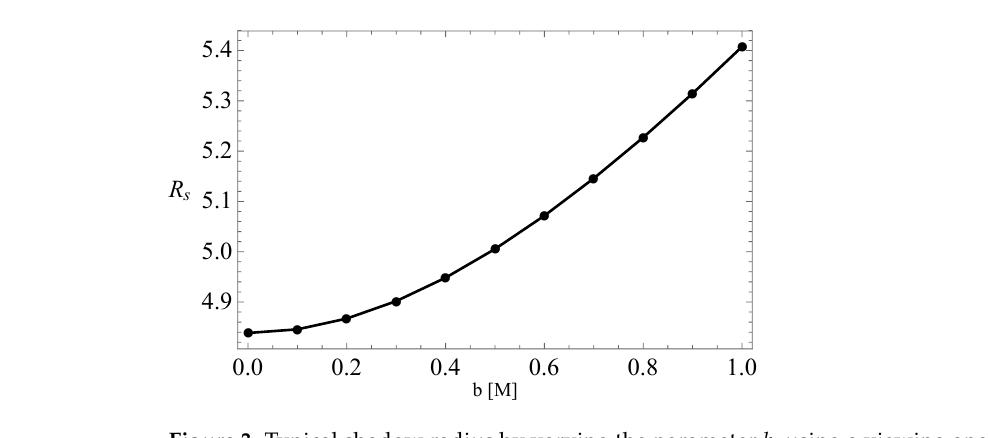
Figure 3. Typical shadow radius by varying the parameter b , using a viewing angle θ 0 = π /2. We have used a =